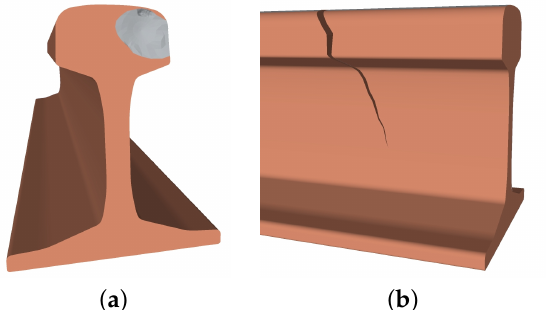
Figure 2. Three-dimensional representation of transverse defects: ( a ) section with shell; ( b ) lateral view.